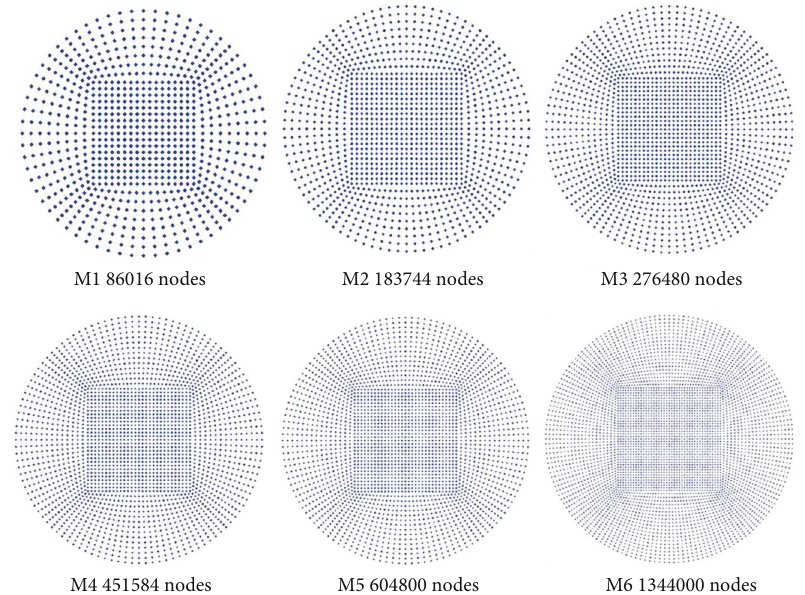
Figure 6: Mesh independence analysis.